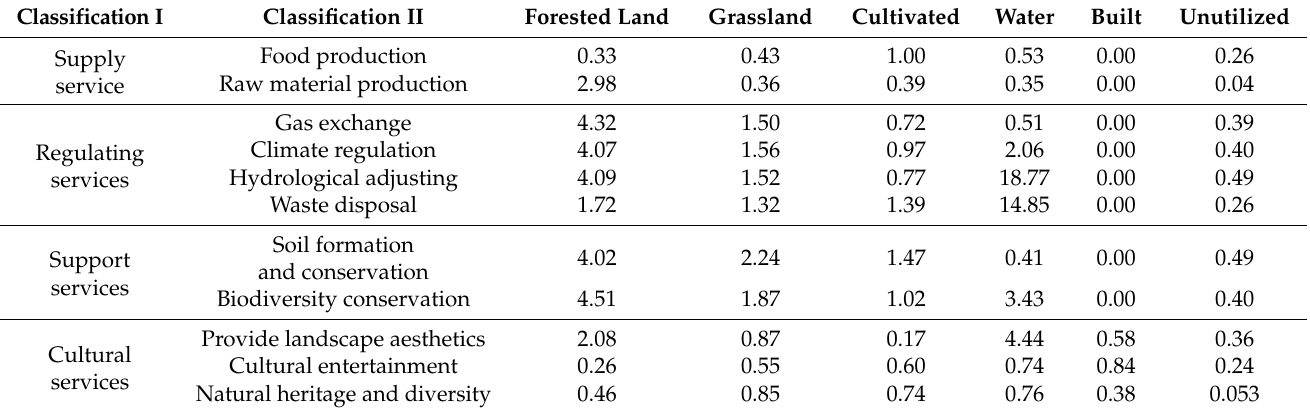
Table 1. ESV equivalent per unit area of ecosystem in Wuhan metropolitan